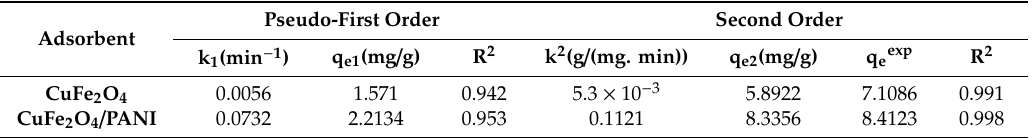
Figure 5. Effect of contact time on adsorption optimization using CuFe 2 O 4 and CuFe 2 O 4 /PANI nano- composites sorbents (V = 30 mL, Hg 2+ concentration = 25 µg/mL, adsorbent amount = 0.1 g CuFe 2 O 4 and 0.2 g CuFe 2 O 4 /PANI and pH 7). Table 2. Adsorption kinetics parameters.